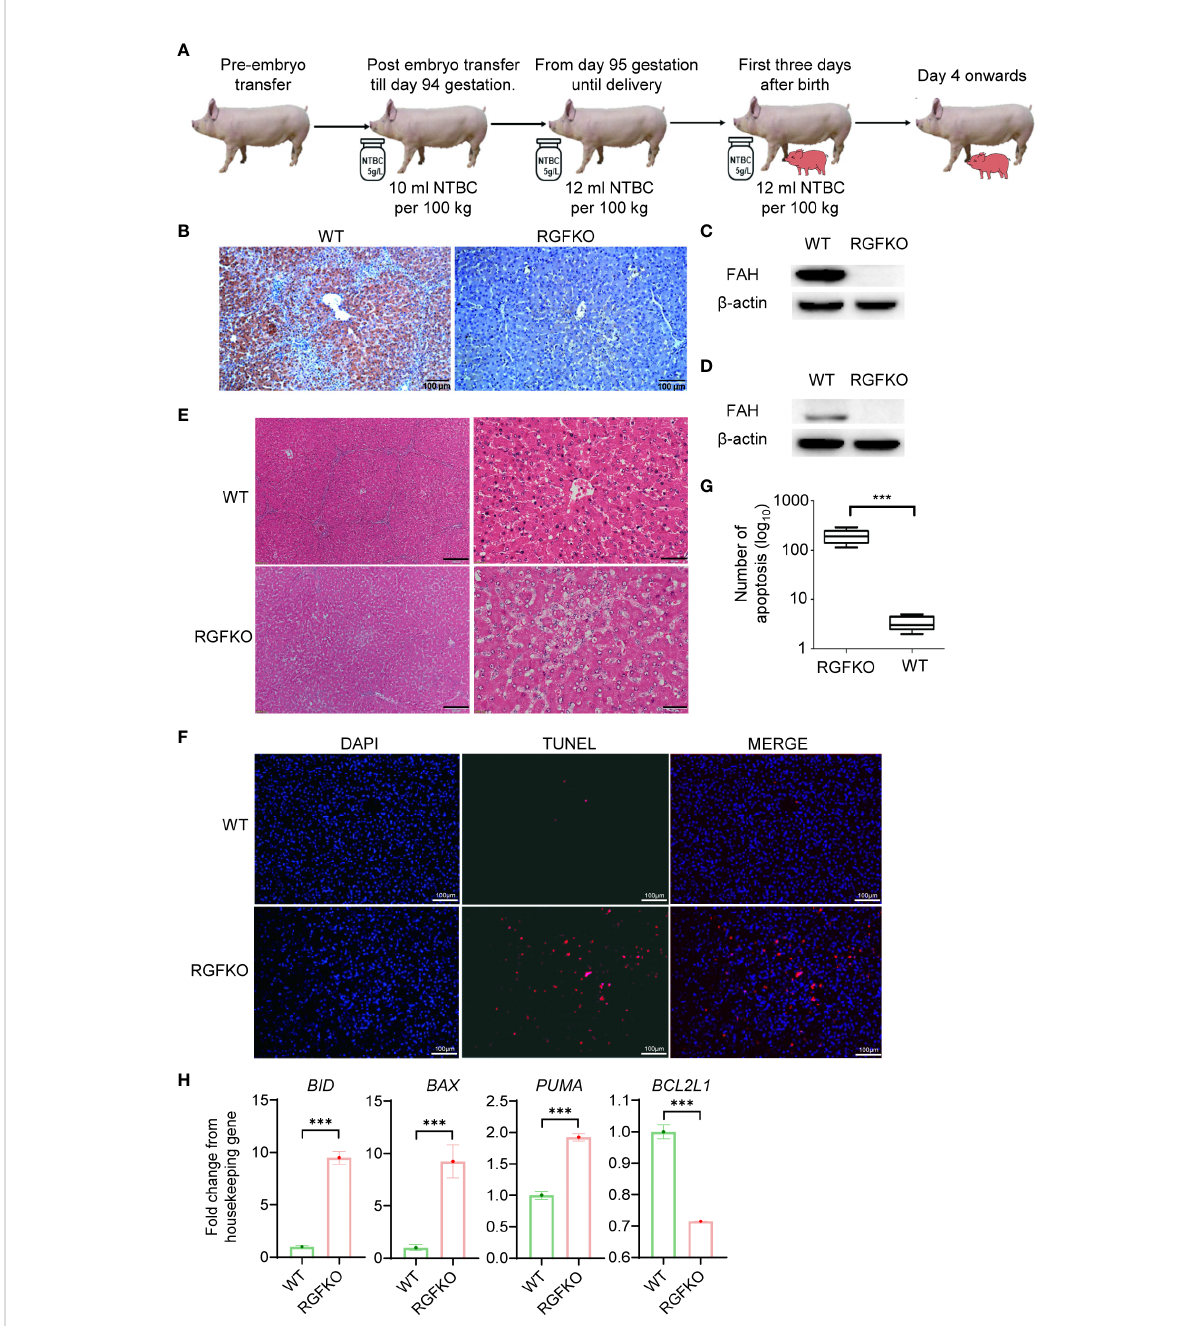
FIGURE 4 RGFKO pigs suffer hepatic damage when taken off NTBC. (A) Schematic of the NTBC dosing regimen for RGFKO pigs. Surrogate sows were supplemented with NTBC (5g/L) at a dose of 10 ml NTBC per 100 kg body weight for the fi rst 94 days of gestation. NBTC dose was increased to 12 ml NTBC per 100 kg body weight thereafter until delivery of RGFKO piglets. RGFKO piglets were supplemented with 12 ml NTBC per 100 kg body weight for the fi rst 3 days after birth. NTBC was then withdrew after that. (B) FAH immunohistochemistry analysis of the liver of RGFKO and wildtype (WT) pigs using anti-FAH. (C, D) Western blot analysis of the expression of FAH in hepatocytes (C) and testes (D) of RGFKO and WT piglets. b -actin was used as a loading control. (E) Representative liver sections of WT and RGFKO piglets stained with haematoxylin and eosin. Boxed region was magni fi ed to show diffuse hepatocellular injury and cytoplasmic ballooning degeneration. (F, G) Evaluation of hepatocyte apoptosis via TUNEL assay was performed on liver sections of RGFKO and WT pigs. DAPI (blue) was used to stain the nuclei of hepatocytes, while TUNEL positive cells were stained red (F) . TUNEL positive cells were quanti fi ed through image analysis (G) . (H) qPCR analysis of the expression of the indicated genes in hepatocytes of RGFKO and WT piglets. Shown are fold change of the indicated genes over housekeeping genes (GAPDH). Data shown are mean ± standard error (n = 2 for RGFKO, n = 3 for WT). ns, not signi fi cant. *** p <